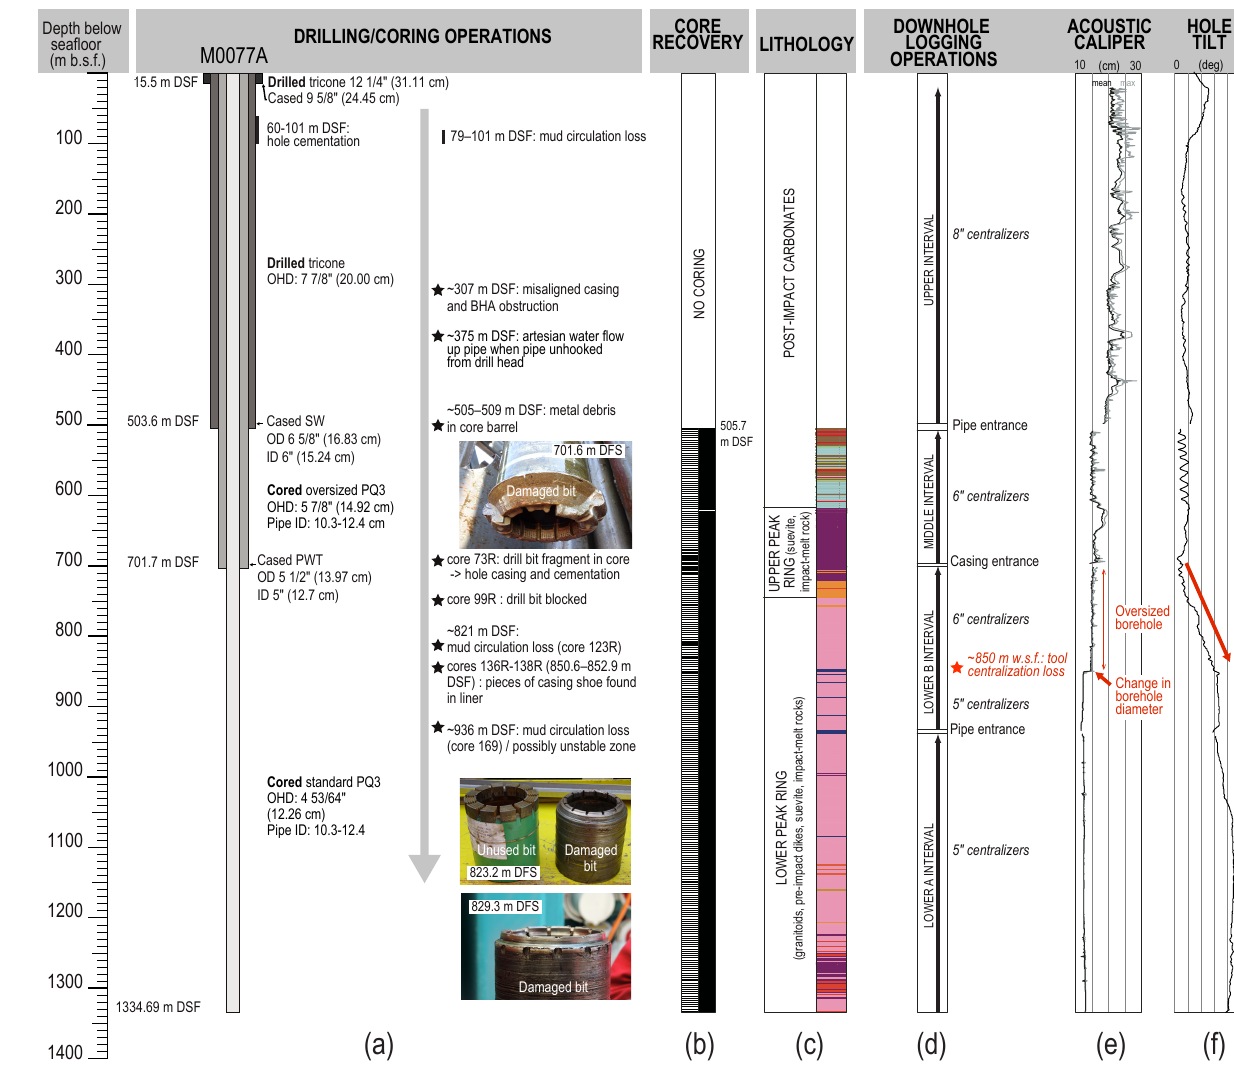
Figure 1. Summary of drilling, coring, and logging operations at Site M0077. The downhole logging data were acquired with slimline tools in three different phases (upper, middle, and lower intervals). Note the change in borehole diameter at ∼ 850mw.s.f. (wireline seafloor) preceded by an increase in the borehole tilt (see discussion in Sect. 4.3). Pictures illustrate damaged drill bits. ID is the inner diameter, OD the outer diameter, and OHD the open hole diameter; mb.s.f. is meters below seafloor and DSF is the driller’s depth below